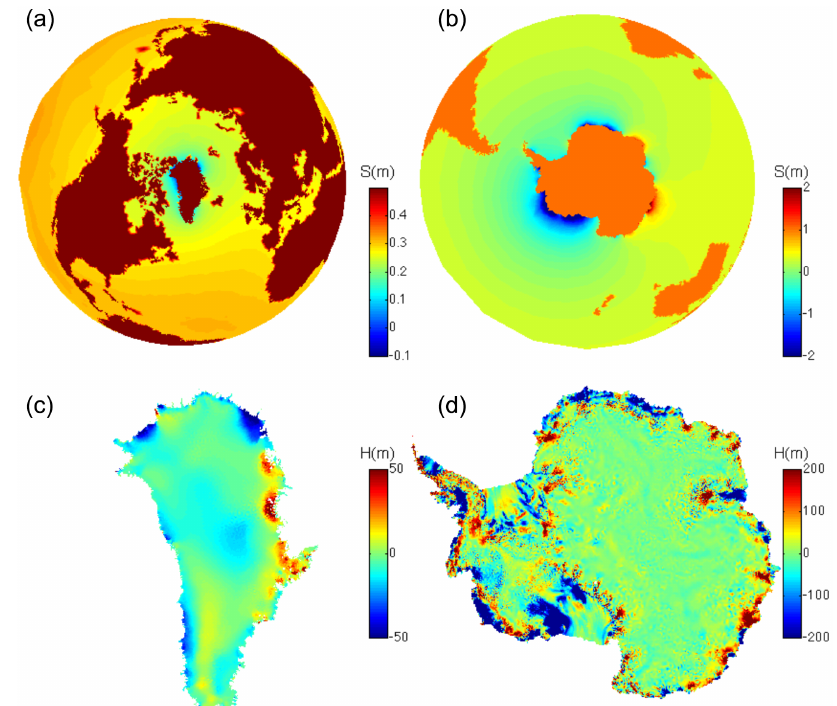
Figure 8. Sea-level fingerprints of high-resolution ice-sheet forcing. The upper frame shows relative sea level computed by ISSM-SEASAW at the end of a 200-year control run of both polar ice sheets. The corresponding ice forcings (e.g., Schlegel et al., 2015) are shown in the lower frame. Close-ups on Greenland (frames a and c ) and Antarctica ( b, d ) are provided for convenience. We do not account for rotational feedback in this particular set of